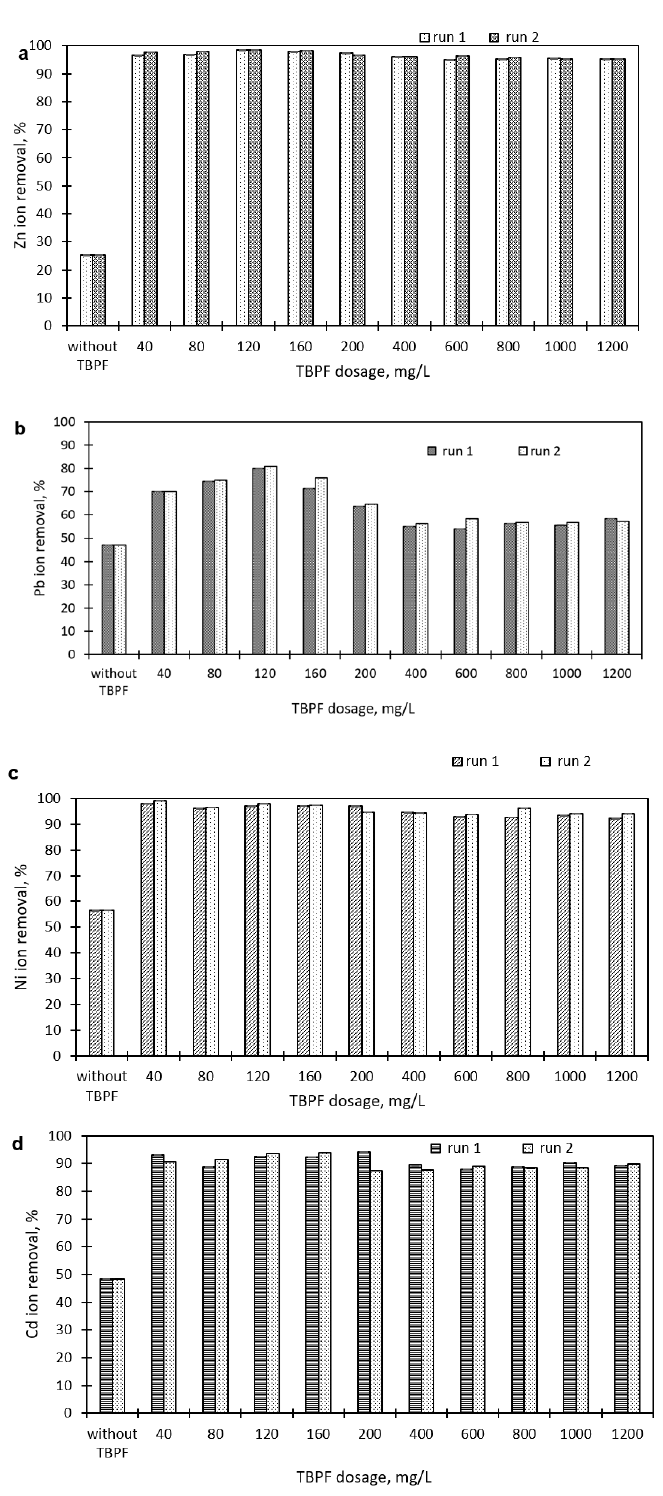
Figure 5. Effect of TBPF dosages on metal ion removal: ( a) Zn, ( b ) Pb, ( c ) Ni, and ( d ) Cd at pH 10 in a 2.5 mg/L metal ion concentration.